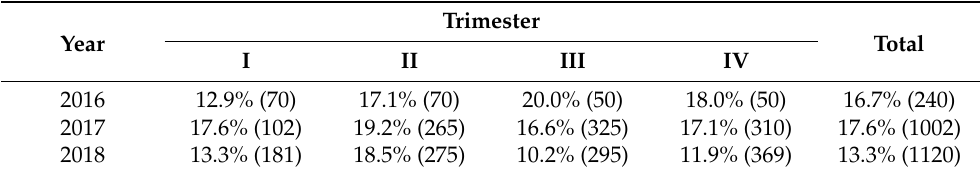
Table 2. Percentage of schools with positive containers registered between 2016 and 2018 in Medell í n. The total amount of institutions inspected is included in parentheses.